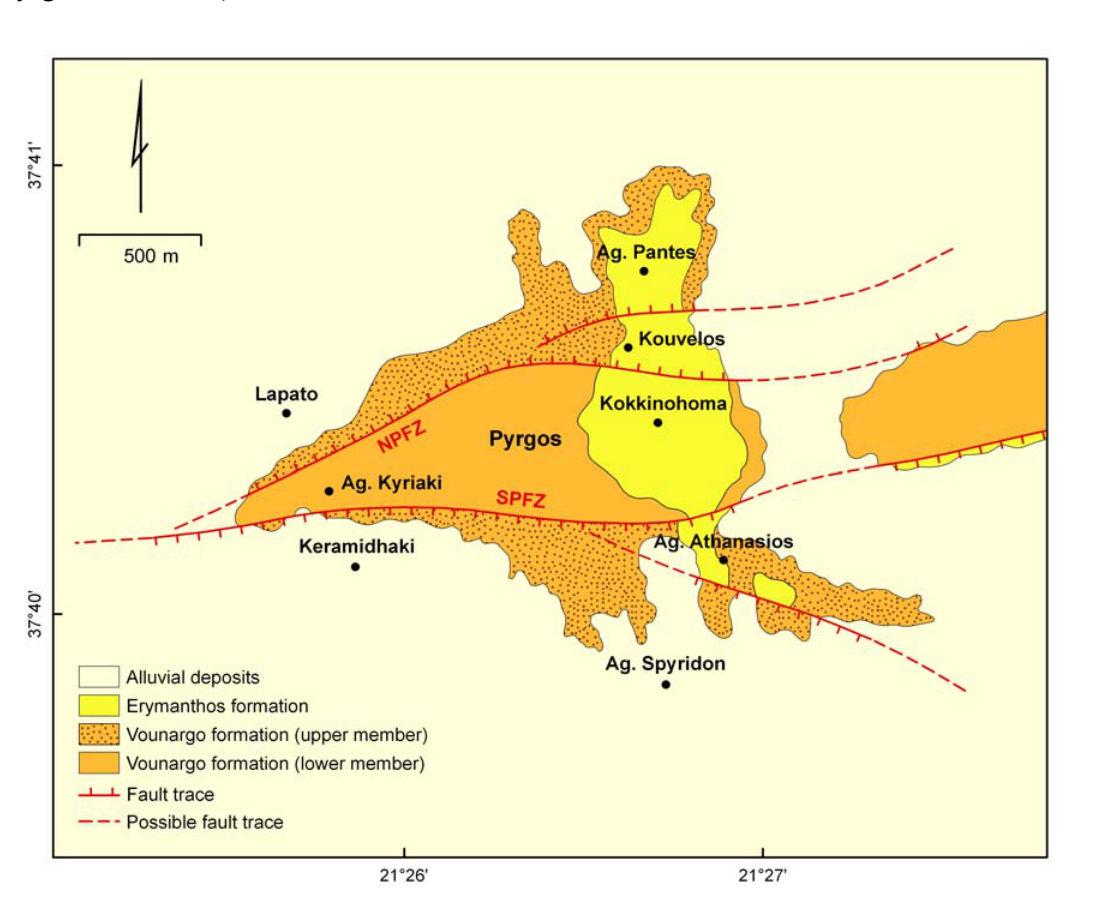
Figure 3. Geological map of Pyrgos City (NPFZ: North Pyrgos Fault Zone; SPFZ: South Pyrgos Fault